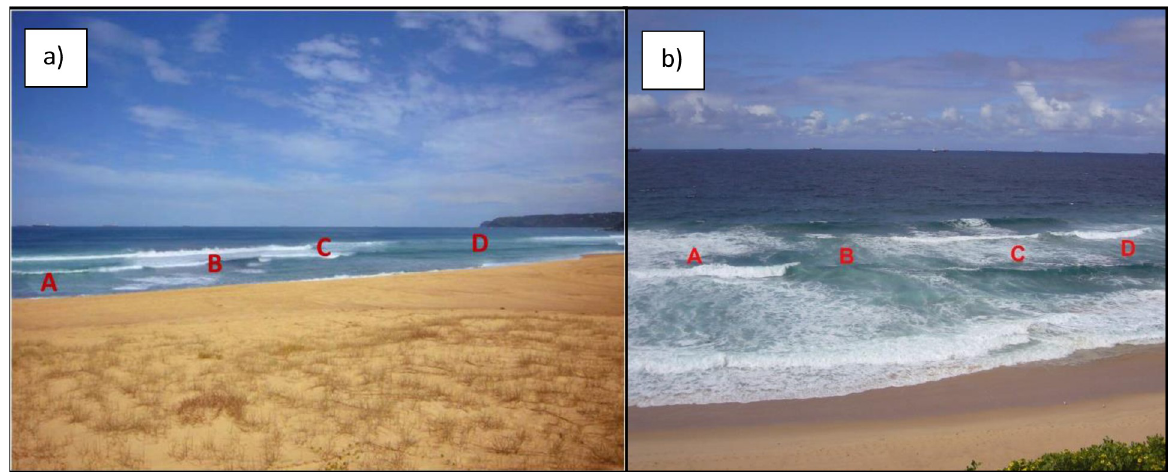
Fig 2. Pictures in the surf life saving Australia national coastal safety survey shown with each question asking ‘Please look at the picture below and identify the location of rip currents, if any. (Select all that apply )’ to which the responses are coded as (0) No rip currents in this picture, (1-4) Location A through to Location D, and (99) can’t